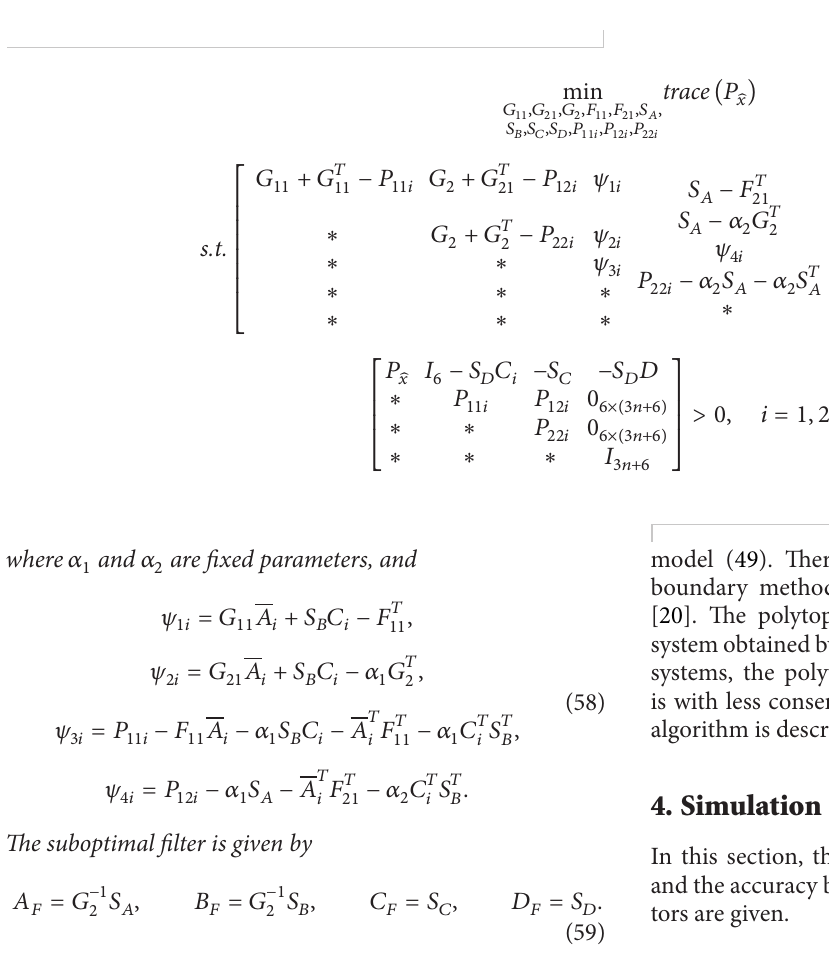
Table 1: The improved computationally efficient attitude estimator. Step 1 . Determine the vertexes of the polytopic linear model described as (50). Step 2 . Search for optimal solutions (𝐺 2 , 𝑆 𝐴 ,𝑆 𝐵 ,𝑆 𝐶 ,𝑆 𝐷 ) of LMIs (57); then calculate the constant filter coefficients (𝐴 𝐹 , 𝐵 𝐹 , 𝐶 𝐹 , 𝐷 𝐹 ) for the local attitude estimator by (59). ,̂𝑏 , ̂𝜔 𝑢 , 𝑟 Given ̂𝑞 𝑘−1 𝑘−1 𝑘−1 and measurements 𝑘 𝑏𝑘 , one has the following. ̂𝑏 Step 1 . Compute the attitude predictions ̂𝑞 𝑘/𝑘−1 and 𝑘/𝑘−1 by (20). Step 2 . Compute measurement prediction errors Δ𝑟 𝑏𝑘 by (21). Step 3 . Compute the local error attitude estimation Δ̂𝑥 𝑘 by (50). ̂𝑏 Step 4 . Update the attitude estimations ̂𝑞 𝑘 and 𝑘 by (26) and (27). ̂𝑏 Step 5 . Update the angular velocity estimation: ̂𝜔 𝑘 = 𝑢 𝑘 − 𝑘